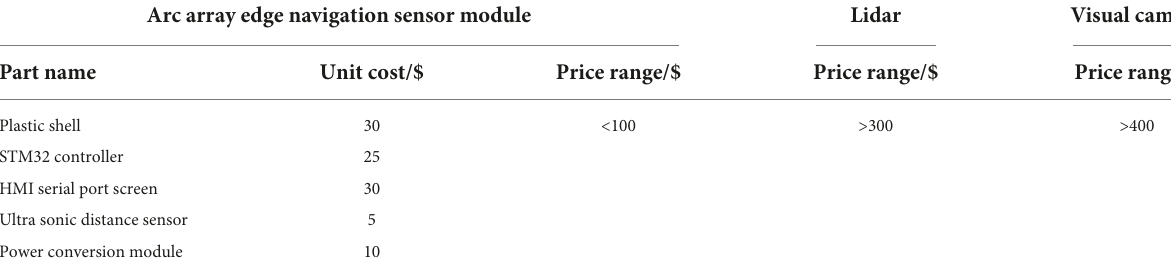
TABLE 2 Manufacturing cost of an arc array edge navigation sensor